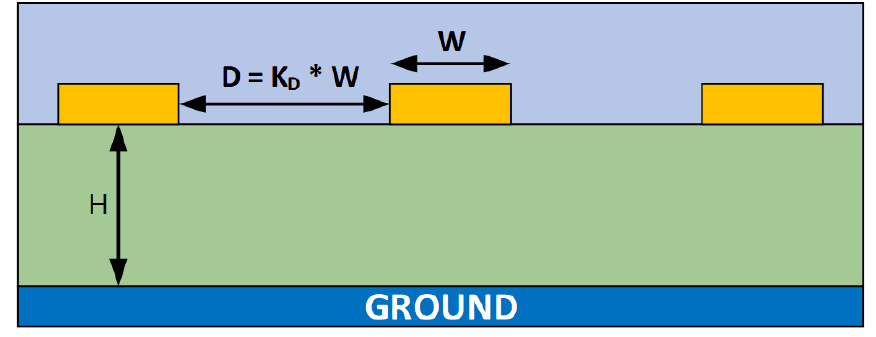
Figure 6. Cross-section of microstrip line structure with a single-ended